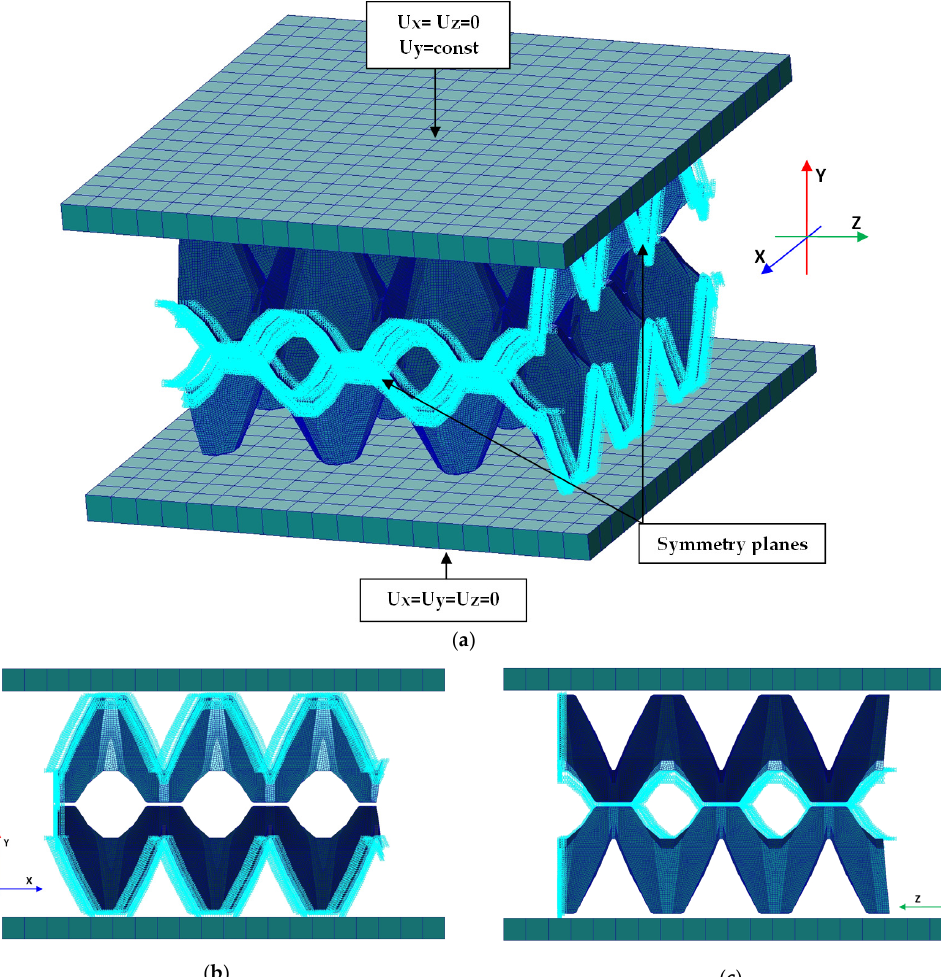
Figure 10. Numerical models with boundary conditions ( a ), view of discrete model in the plane X —Y ( b ) and view of discrete model in the plane Y—Z ( c ).